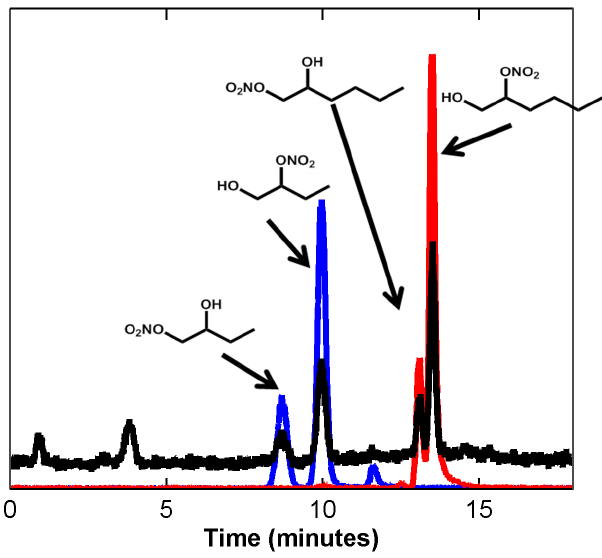
Figure 43. GC-CIMS/TD-LIF chromatogram following Exp. 15. Figure 3. GC-CIMS/TD-LIF chromatogram following Exp. 15. The The signals due to individual hydroxy nitrates are determined by signals due to individual hydroxy nitrates are determined by inte- integrating the alkyl nitrate peaks (black line, elevated baseline) grating the alkyl nitrate peaks (black line, elevated baseline) which which co-elute with the individual hydroxy nitrates observed by co-elute with the individual hydroxy nitrates observed by CIMS, CIMS, e.g. hydroxy nitrates from 1-butene at 220 m/z (blue) and from 1-hexene at 248 m/z . Absolute CIMS sensitivities are deter- e.g., hydroxy nitrates from 1-butene at 220 m/z (blue) and from mined by integrating individual peaks for CIMS signal and TD-LIF 1-hexene at 248 m/z . Absolute CIMS sensitivities are determined signal and dividing. The assigned chemical structures are shown for by integrating individual peaks for CIMS signal and TD-LIF signal each alkyl nitrate peak. and dividing. The assigned chemical structures are shown for each alkyl nitrate